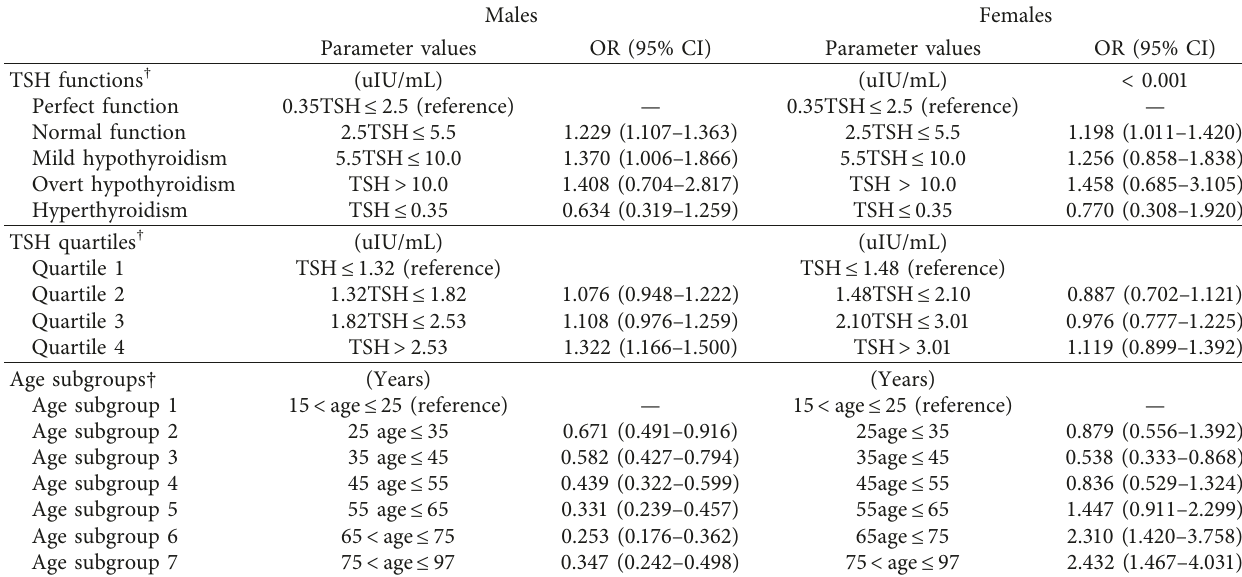
Table 4: The risks of developing HUA in different